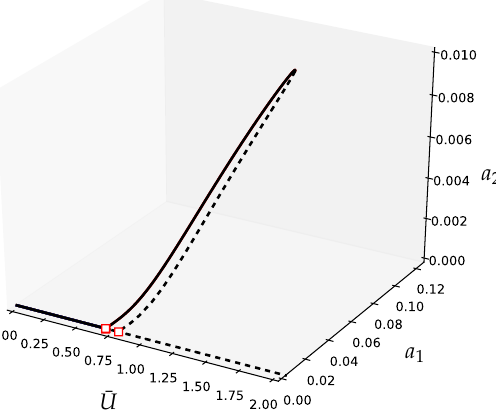
Figure 6. Bifurcation diagram for σ e = 0, σ i = 0, case NCL-NL (solid line: stable; dashed line: unstable).